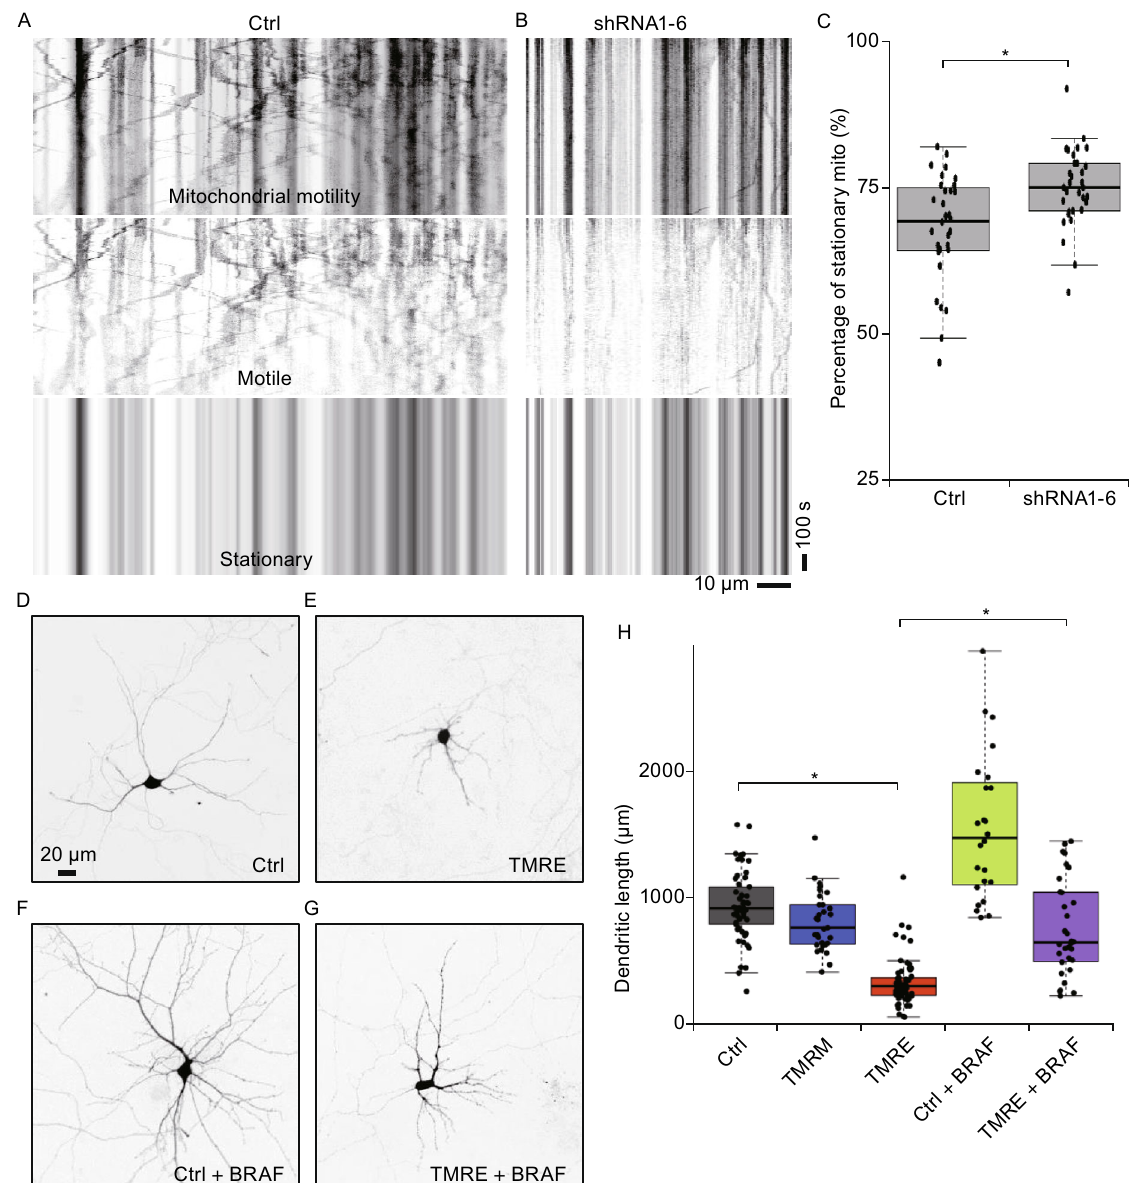
Figure 5. BRAF overexpression also protects against dendritic atrophy caused by mitochondrial dysfunction in primary hippocampal neurons. (A and B) Dync1i1 Knockdown decreases dendritic mitochondrial motility in primary hippocampal neurons. For clarityandquanti fi cation,motileandstationarydendriticmitochondriaareseparatedwithfastFouriertransform(FFT)algorithm.Kymographs show active mitochondrial motility in control neuron (A, Ctrl) and a few motile dendritic mitochondria in DYNC1I1-knockdown neuron (B, shRNA1-6).Inkymographs,verticallinesrepresentstationarymitochondria,andslantlinesorcurvesindicatemotilemitochondria.Neurons are co-transfectedat DIV6 with DsRed-mito andcontrol vector (A) or shRNA1-6(B), imaged atDIV11 andsequentiallyanalyzed.The scale barsrepresent10 μ m(xaxis)and100seconds(yaxis).(C)Scatterplotswithboxplotsshowthepercentagedistributionofstationarydendritic mitochondria in neurons transfected with control vector ( n = 32) or shRNA1-6 ( n = 32). (D – G) BRAF overexpression also protects against dendriticatrophycausedbymitochondrialdysfunction.Neuronsaretransfectedwithcontrolvector(Ctrl)orBRAFtreatedwithcontrolsolution or with 50 nmol/L of speci fi c mitochondrial function inhibitor TMRE at DIV6, culturedadditional 5 days and imagedat DIV11.The scalebars represent20 μ m. (H) Scatterplots with boxplots show thetotaldendriticlength distributionofneuronstransfected with control vector treated with vehicle(Ctrl, n = 53, gray), with 50 nmol/L of TMRM ( n = 31, blue) or50 nmol/L of TMRE ( n = 63, red), or transfected with BRAFtreated without ( n = 24, green) or with 50 nmol/L of TMRE ( n = 32, purple). *, P <